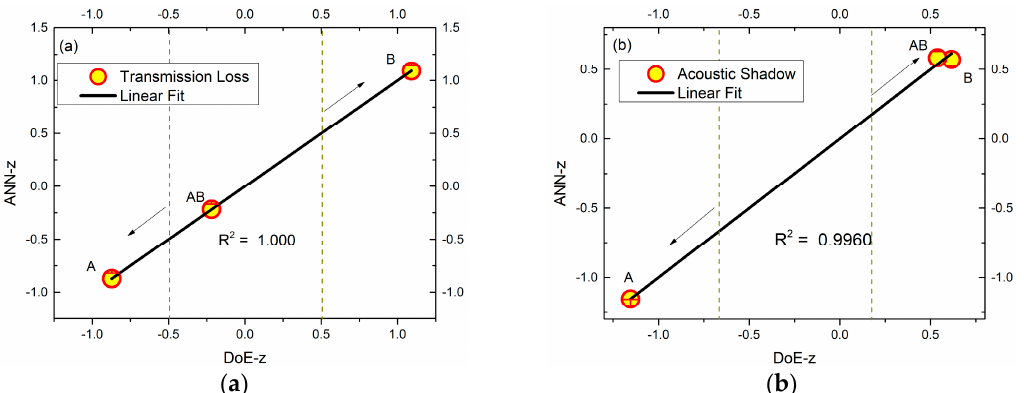
Figure 10. Significance effects of factors “A,” “B”, and “AB” on the z-score scale and correlation of the Design of Experiments (DoE) and Artificial Neural Networks (ANN) results. ( a ) Transmission Loss as a response; ( b ) Area of the acoustic shadow as a response.